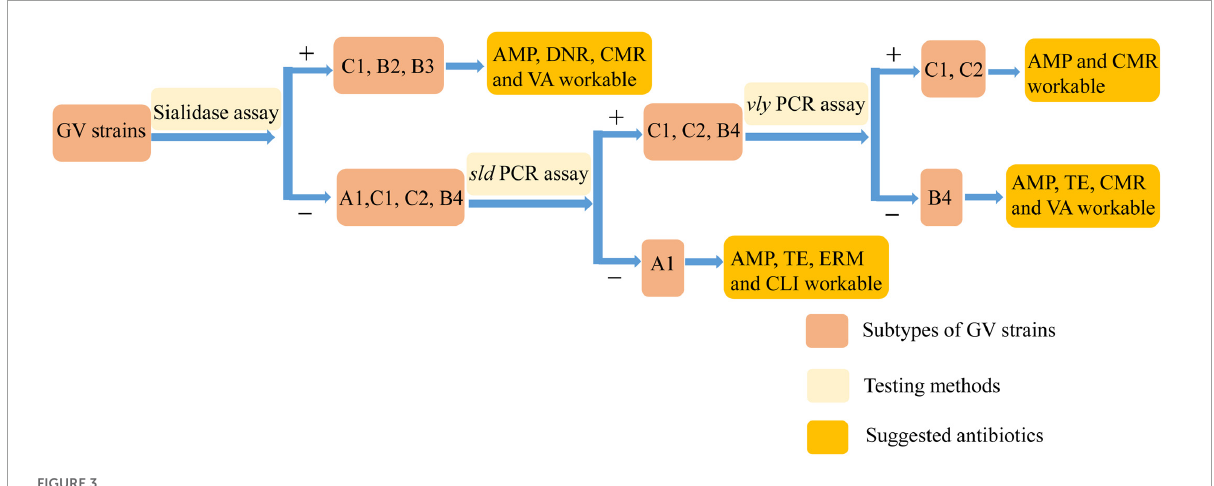
FIGURE3 The diagnose pathway of Gardnerella strains.